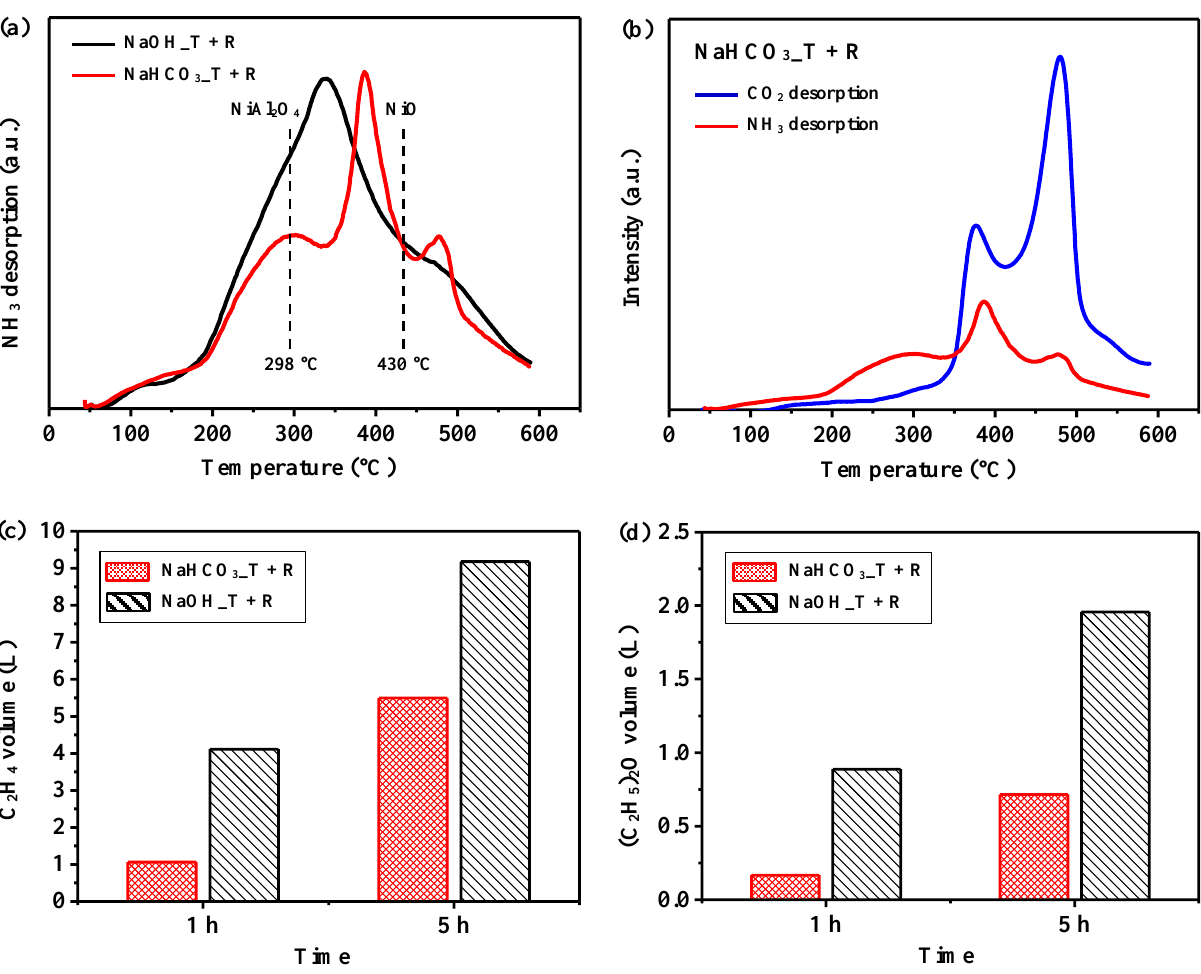
Figure 13. ( a ) NH 3 -TPD profiles of the NaOH_T + R and NaHCO 3 _T + R catalysts; ( b ) NH 3 /CO 2 -TPD profiles of the NaHCO 3 _T + R catalyst; Gas volumes of the production of the NaOH_T + R and NaHCO 3 _T + R catalysts at the initial and end states in the ESR reactions: ( c ) C 2 H 4 ; ( d ) (C 2 H 5 ) 2 O.